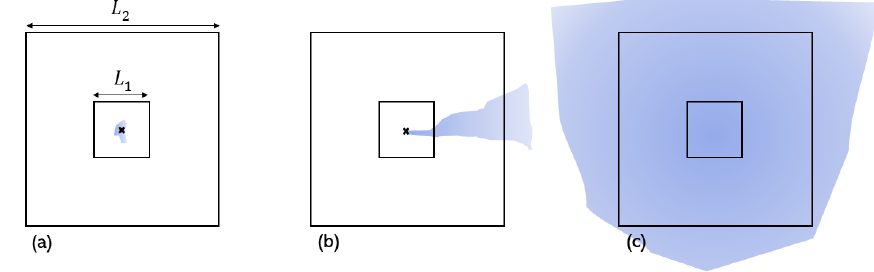
Figure 1. Plume geometry scenarios for illustrating the dependence of detected enhancement (cid:49)(cid:127) on pixel size L .